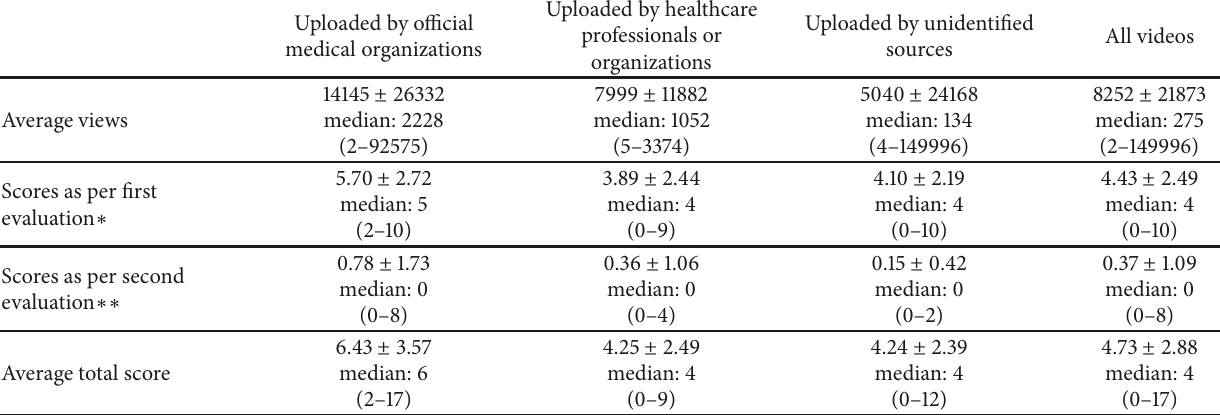
Table 6: Average number of views, average video duration, and scores according to video